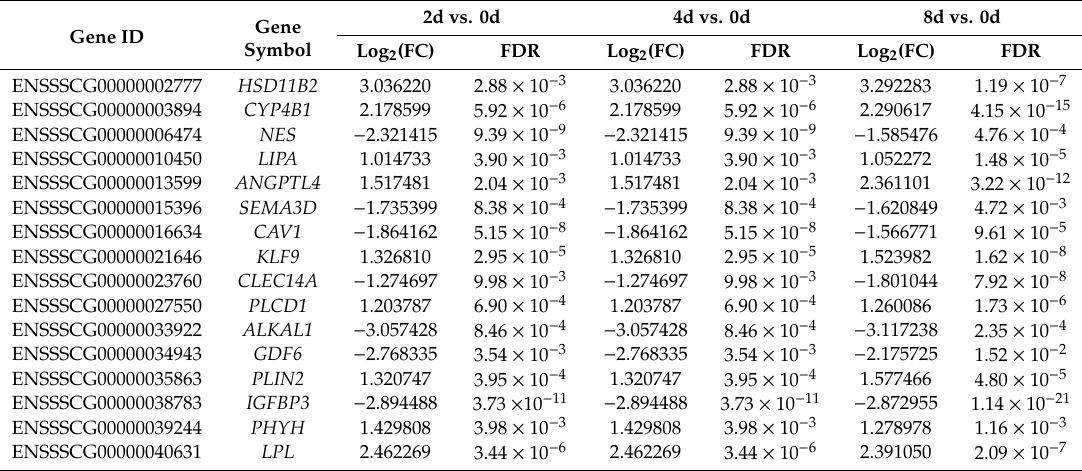
Figure 2. Venn diagram and summary of di ff erentially expressed genes (DEGs) at di ff erent stages. ( a ) Summary of DEGs at four stages. Up represents upregulation at days 2, 4, and 8 vs. day 0. Down represents downregulation at days 2, 4, and 8 vs. day 0. ( b ) Venn diagram of DEGs at three time-point comparisons. Table 2. Summary of 16 DEGs at all three time-point